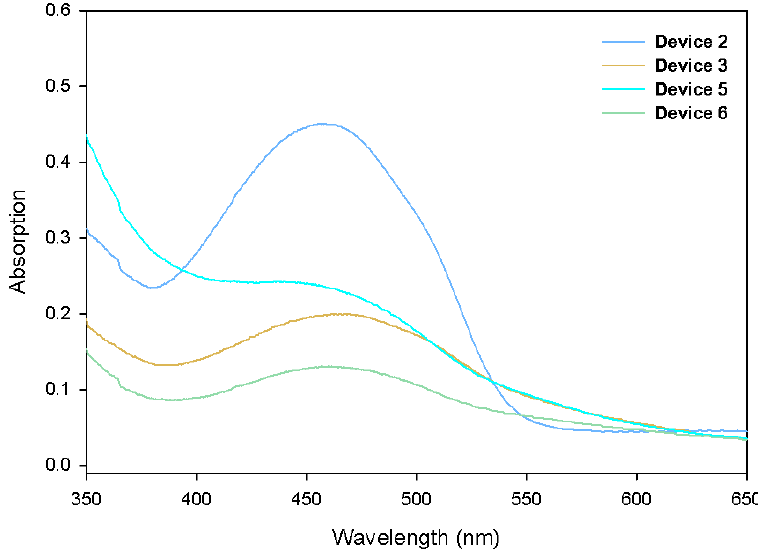
Figure 8. The absorption for the active layers in Devices 2 , 3 , 5 , and 6 .